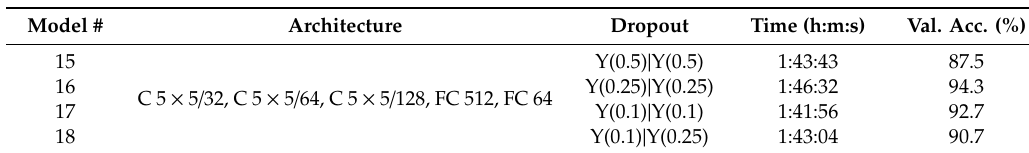
Table 6. Results of fine tuning dropout parameters. The convolutional layers’ parameters are denoted as “C kernel size / number of kernels”. The fully connected layers are denoted as “FC number of hidden units”. Epoch = 300 and learning rate = 1 × 10 − 4 .